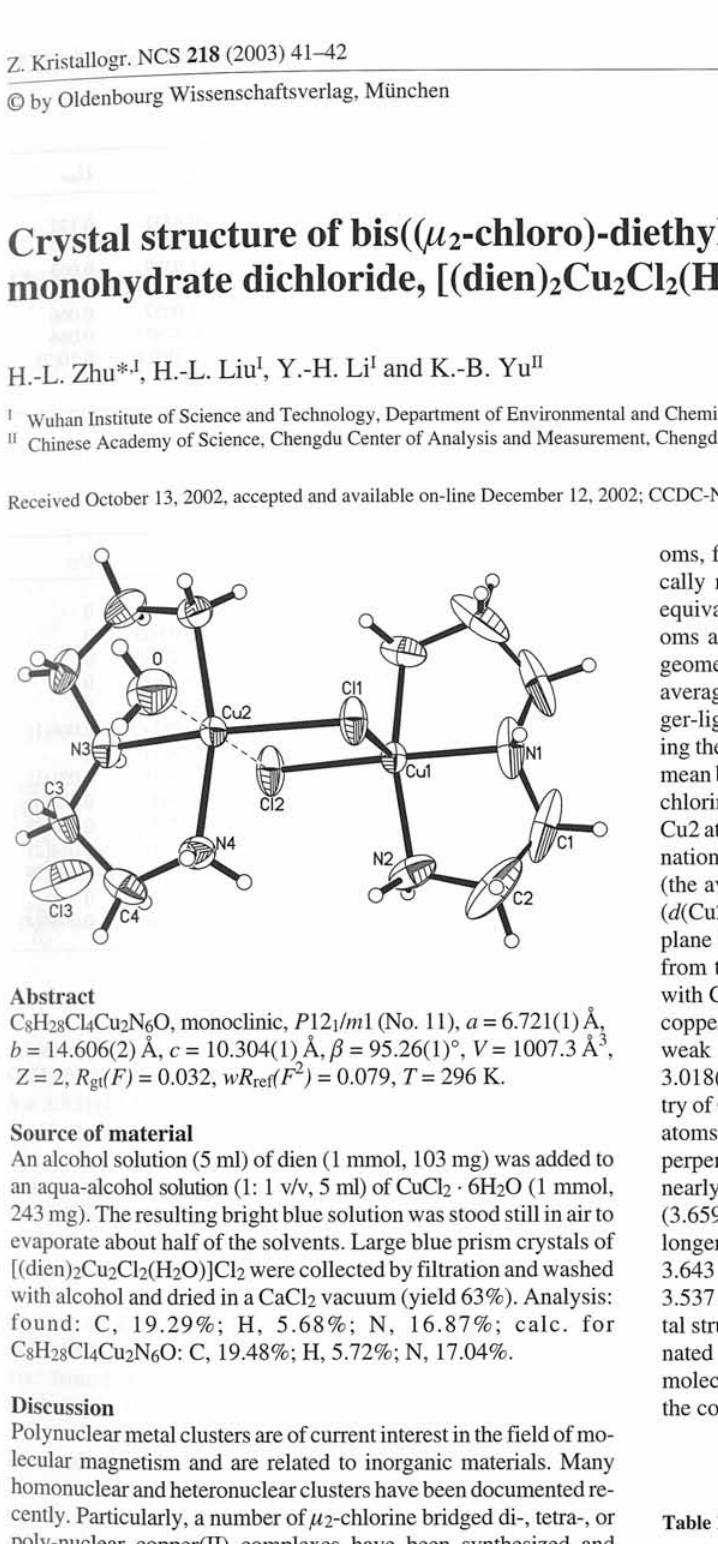
Table 1. Data collection and